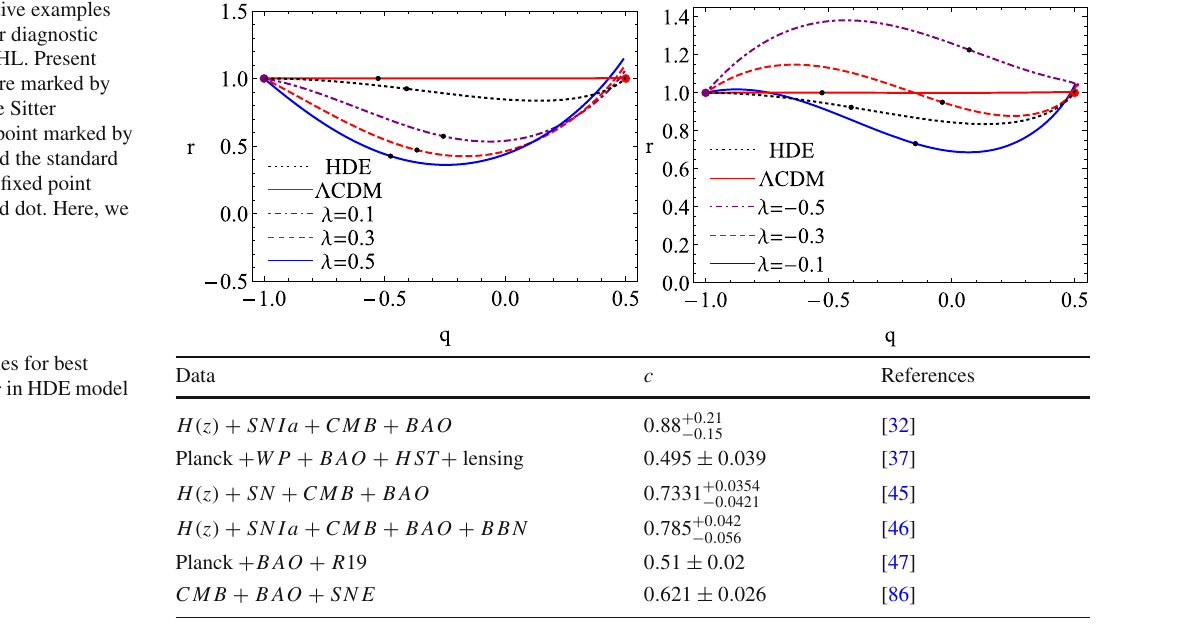
Fig. 25 Illustrative examples for the statefinder diagnostic { r , q } of IBHDEHL. Present values of { r , q } are marked by black dots, the de Sitter expansion fixed point marked by the purple dot and the standard cold dark matter fixed point marked by the red dot. Here, we take (cid:5) = 0 . 8